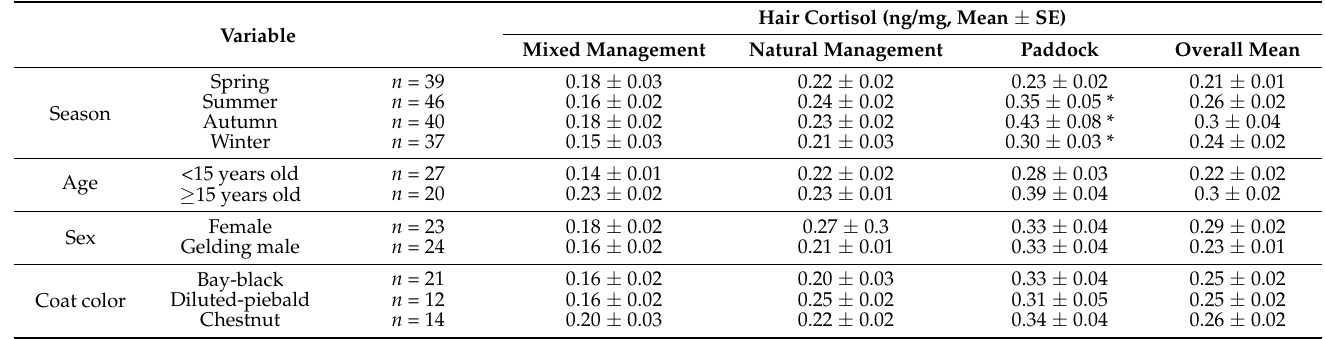
Table 2. Hair cortisol mean values, grouped by season, age, sex, and coat color in different managements. SE = standard error of the mean. * = Significantly higher hair cortisol when different managements are